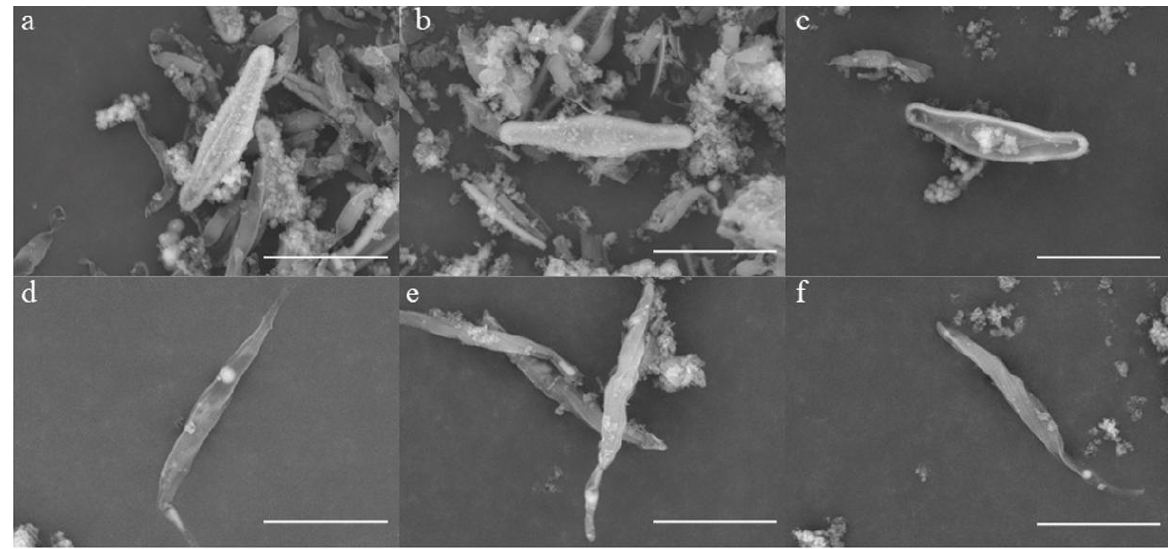
Figure 2 . Cell morphology of P. tricornutum ( a – c ) and C. fusiformis ( d – f ) under different Cu 2+ or Zn 2+ concentrations (control, 5 μM Cu 2+ , and 30 μM Zn 2+ ) recorded on TM4000 Plus SEM. The scale represents 10 μ m.